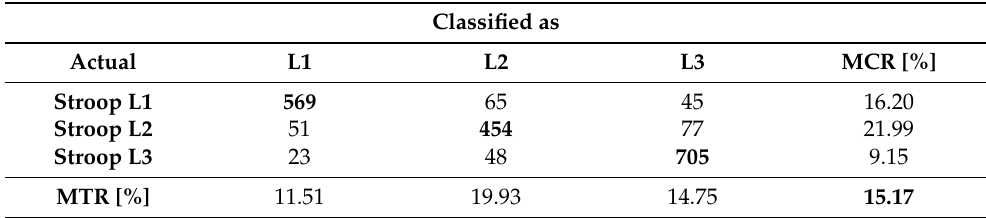
Table 3. Confusion table for the sequence classification for the university cohort. Correctly classified screens are counted on the diagonal (in